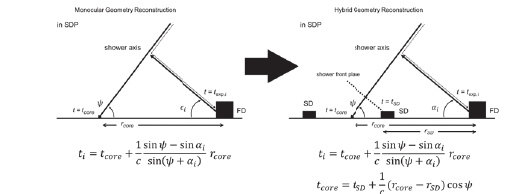
Figure 1: The schematics of the monocular and the hybrid shower geometry reconstruction. The relations between the measured values, which are t exp , i , α i and the fitting pa- rameters, which are t core , r core and ψ . In the hybrid analy- sis, the two observable, t SD and r SD , are added to the rela- tion of the monocular analysis, and as a result the number of the fitting parameter is reduced to two and the geometry determination accuracy is improved.